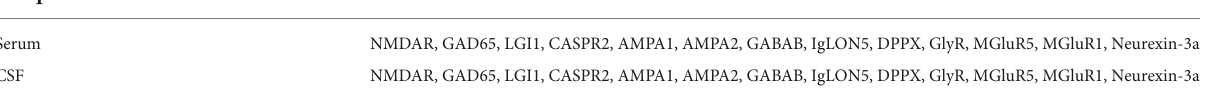
TABLE 2 Antibodies tested in serum and CSF samples.